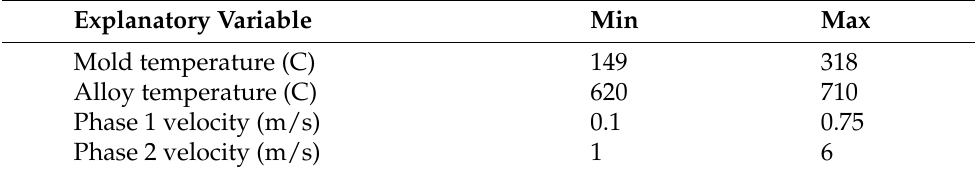
Table 2. Range of the explanatory